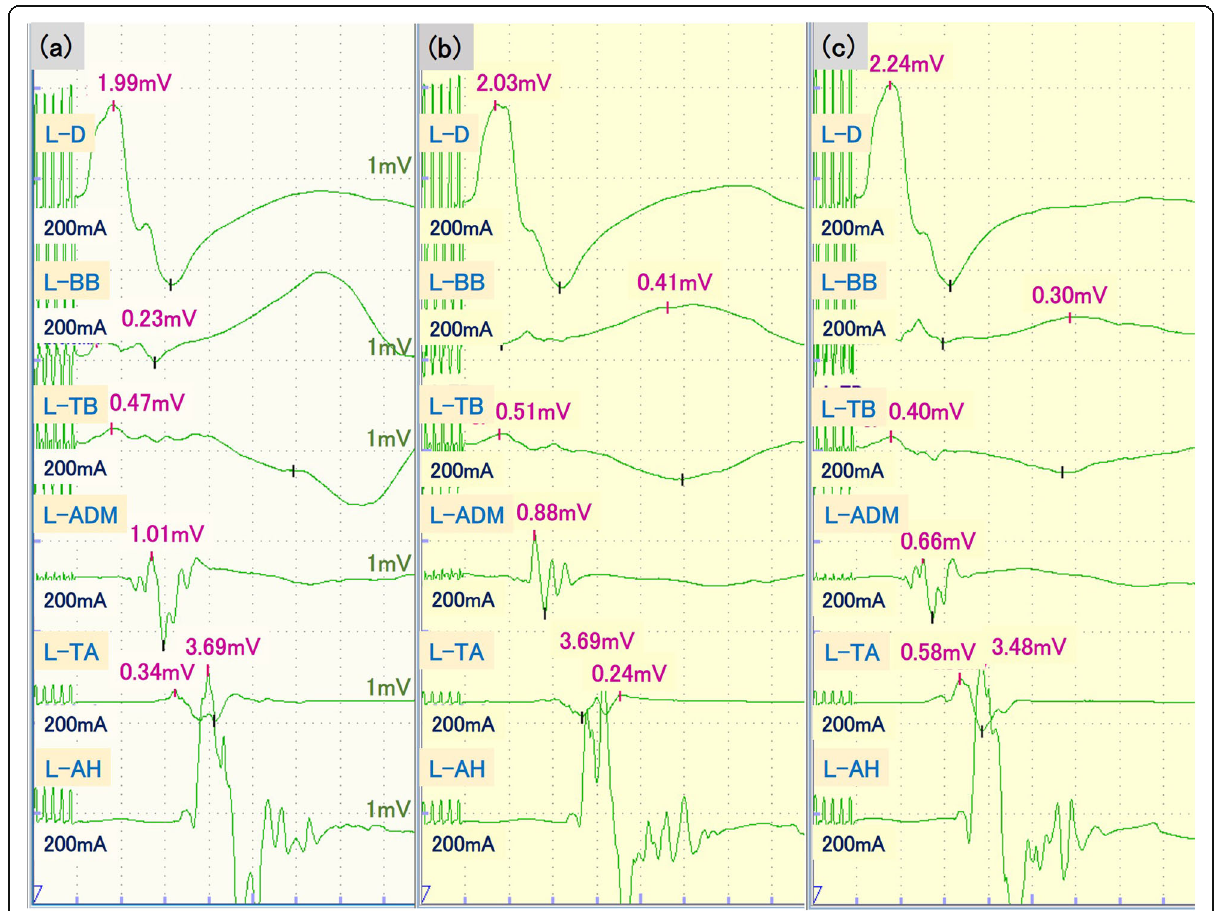
Fig. 1 MEP responses from the left upper and lower extremities before surgery ( a ), during laminoplasty ( b ), and at the end of surgery ( c ) in case 1. Anesthesia was maintained with remimazolam 0.5 mg/kg/h and remifentanil 0.2 μ g/kg/min. D, deltoid; BB, biceps brachii; TB, triceps brachii; ADM, abductor digiti minimi, TA, tibialis anterior; AH, abductor hallucis